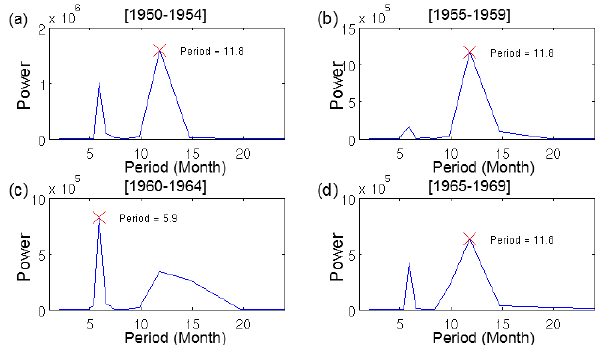
Fig. 21. Periodicities around 1960 in Naivasha estimated from the representative time series of the harmonics. (a) shows the period- icities between 1950 and 1954, (b) between 1955 and 1959, (c) be- tween 1960 and 1964, and (d) between 1965 and 1969. The red cross mark means the major periodicity in each time region.